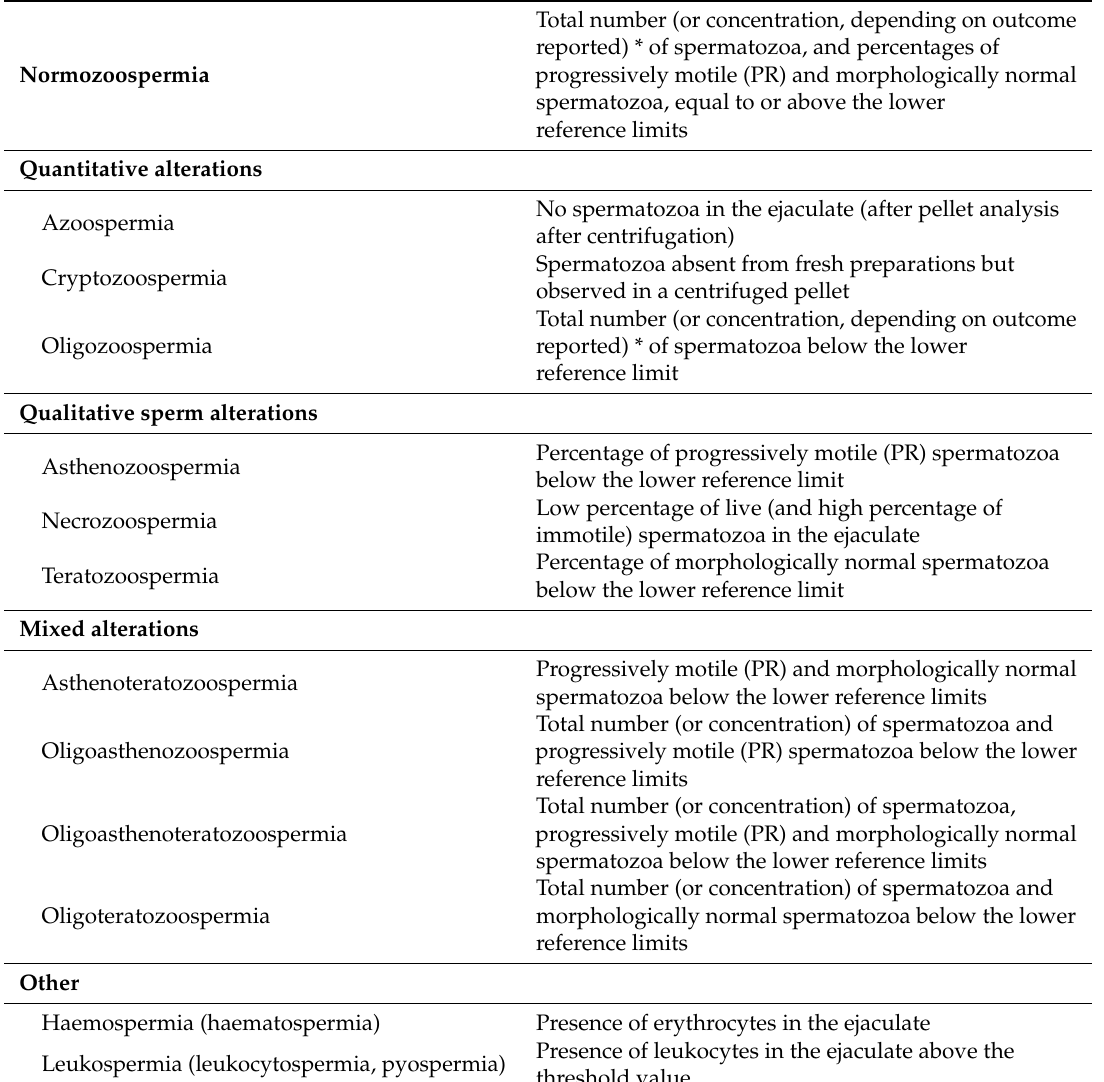
Table 5. Nomenclature related to semen analysis (modified from reference